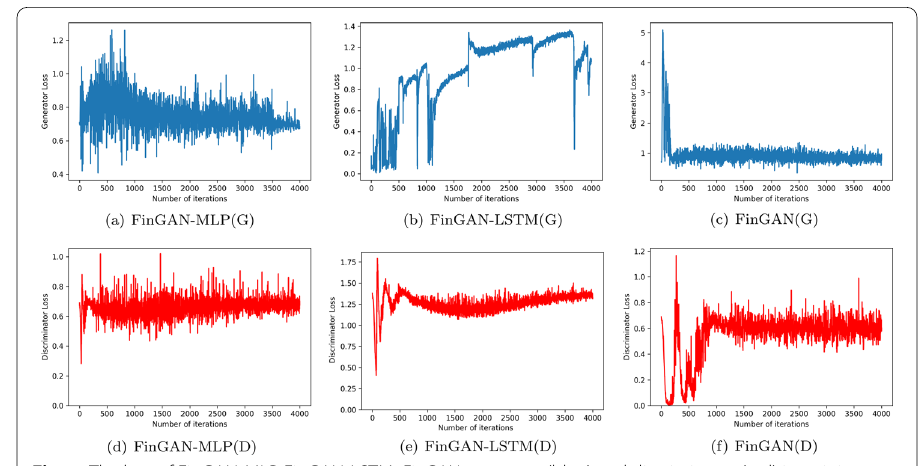
Fig. 5 The loss of FinGAN-MLP, FinGAN-LSTM, FinGAN generator (blue) and discriminator (red) in training are presented respectively. The sample period is from November 16, 2006 through June 30, 2021 and includes 3556